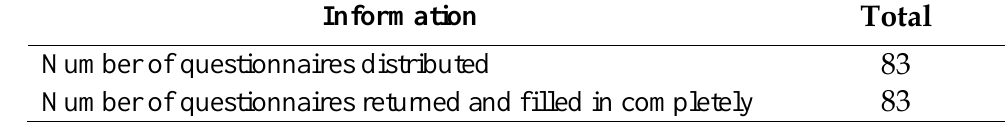
Distribution of